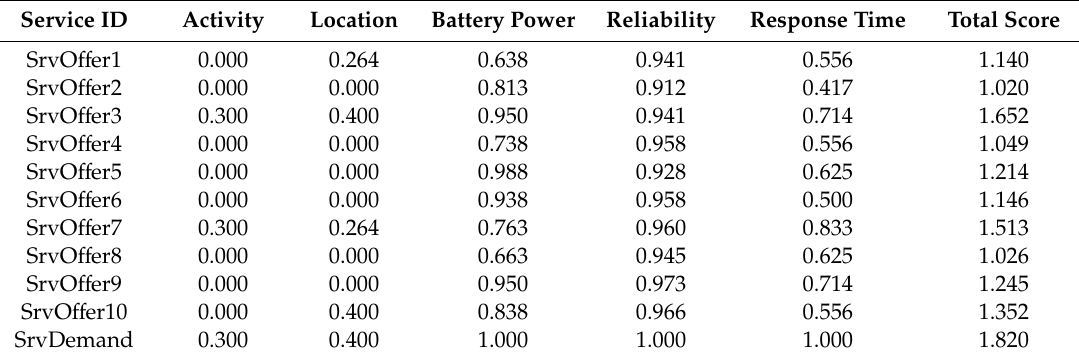
Table 5. Services score computed through the proposed